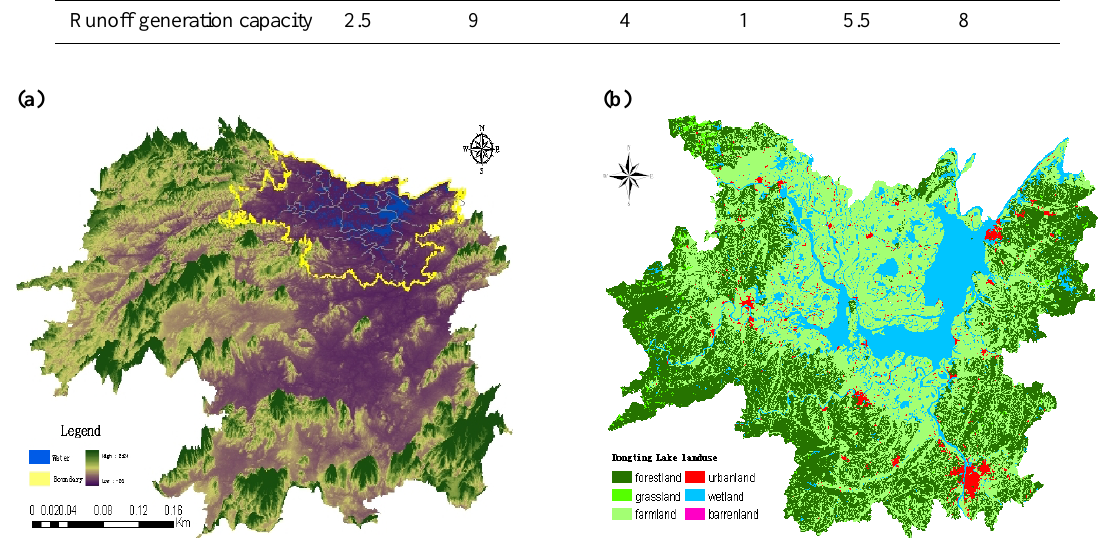
Fig. 5. The elevation (a) and land cover types in the Dongting Lake region (b) .